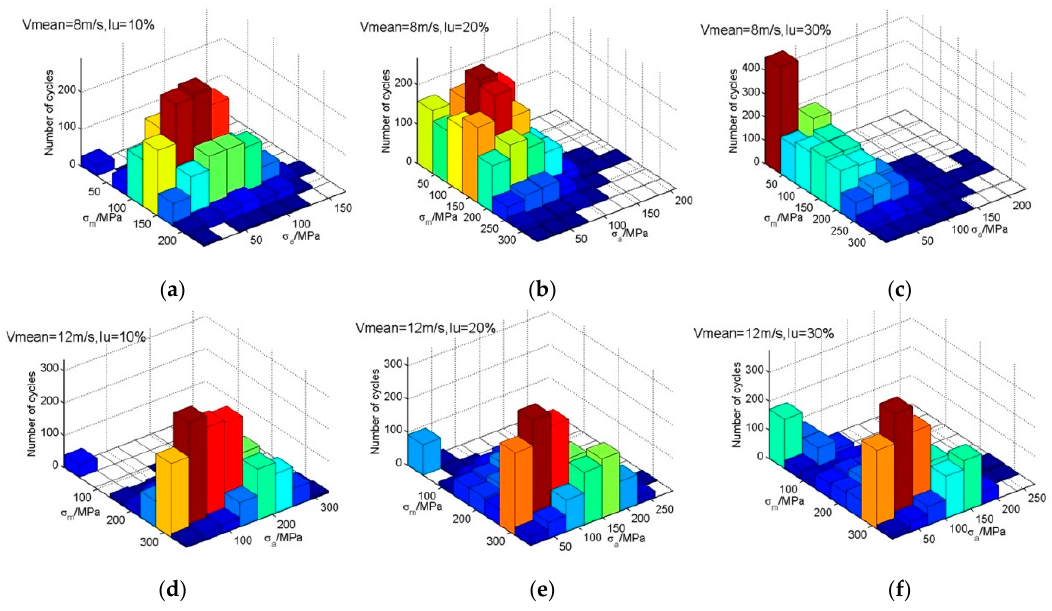
Figure 11. The bending stress between planetary gear and sun gear of 8 m/s with different turbulence intensities: ( a ) 10%; ( b ) 20%; ( c ) 30% and that of 12 m/s with different turbulence intensities: ( d ) 10%; ( e ) 20% and ( f ) 30%.